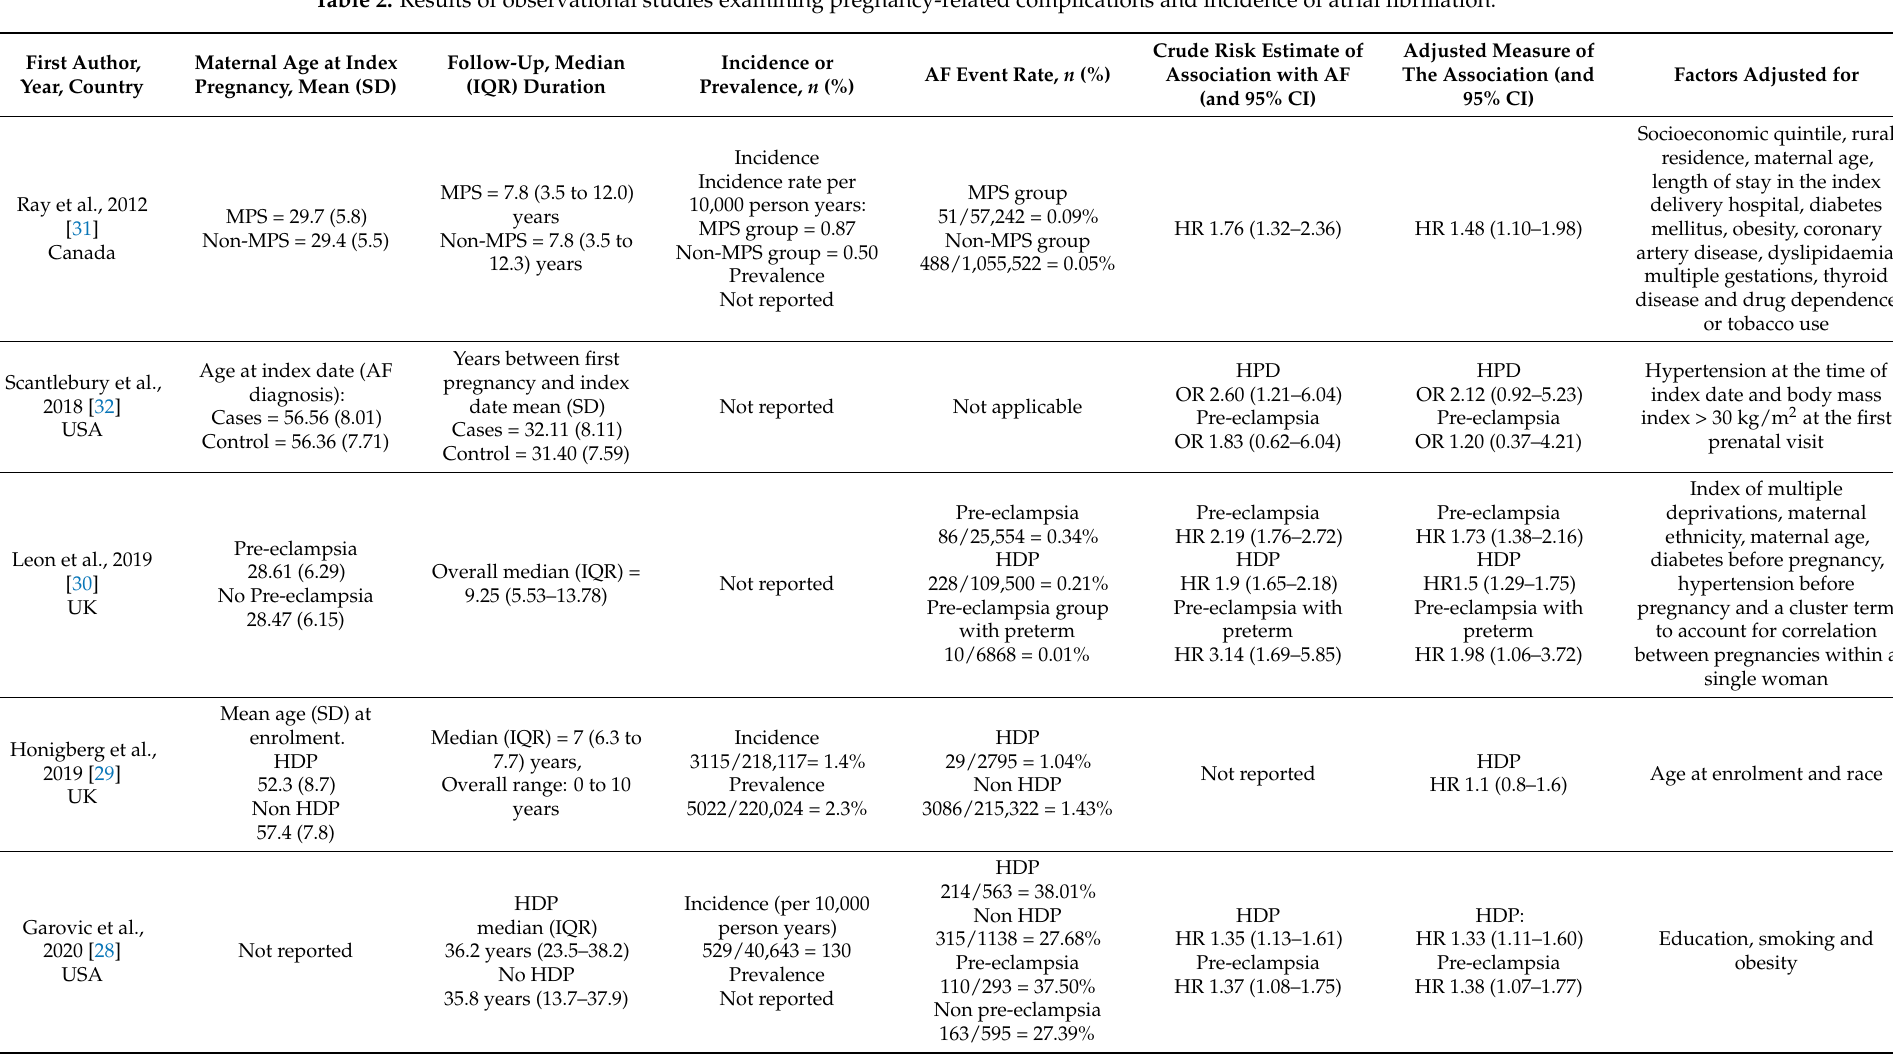
Table 2. Results of observational studies examining pregnancy-related complications and incidence of atrial